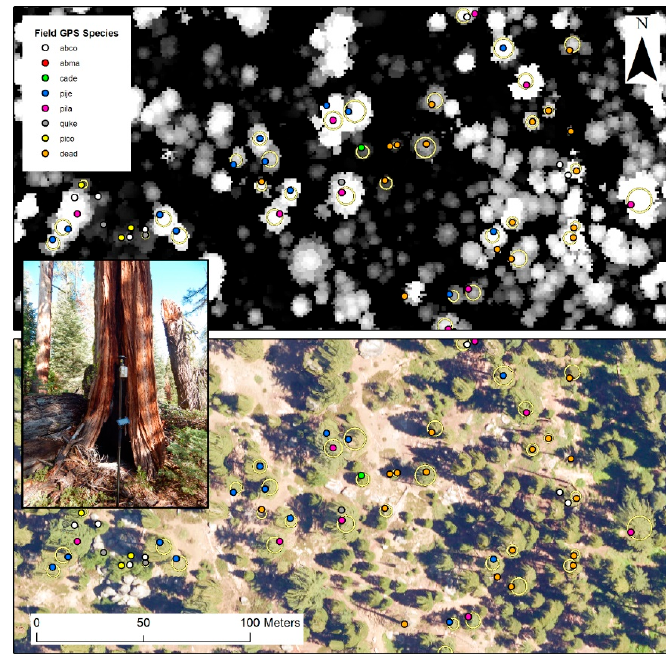
Figure 2. High precision GPS points, colored by species on the Light Detection and Ranging (LiDAR) derived Canopy Height Model (top), the high resolution ortho photos with points labeled using the field measured diameter at breast height (DBH) in centimeters (bottom). Digitized canopy label outlines are shown as yellow circles. The GPS antenna taking a static position next to an Incense cedar ( cade ) tree in the field (center